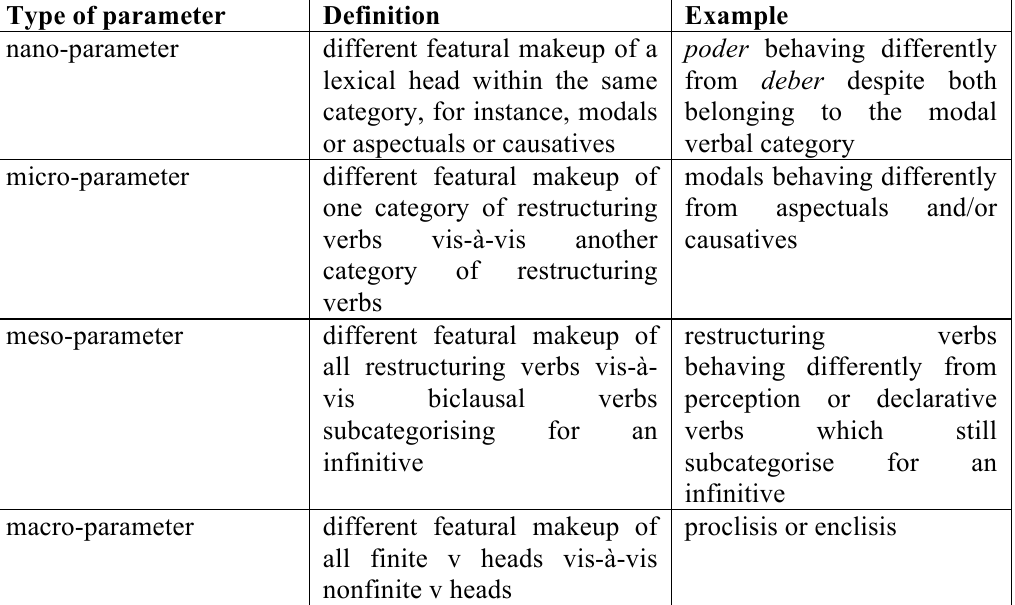
Table 14 . Nano/micro/meso/macro-parametric analysis of CC in